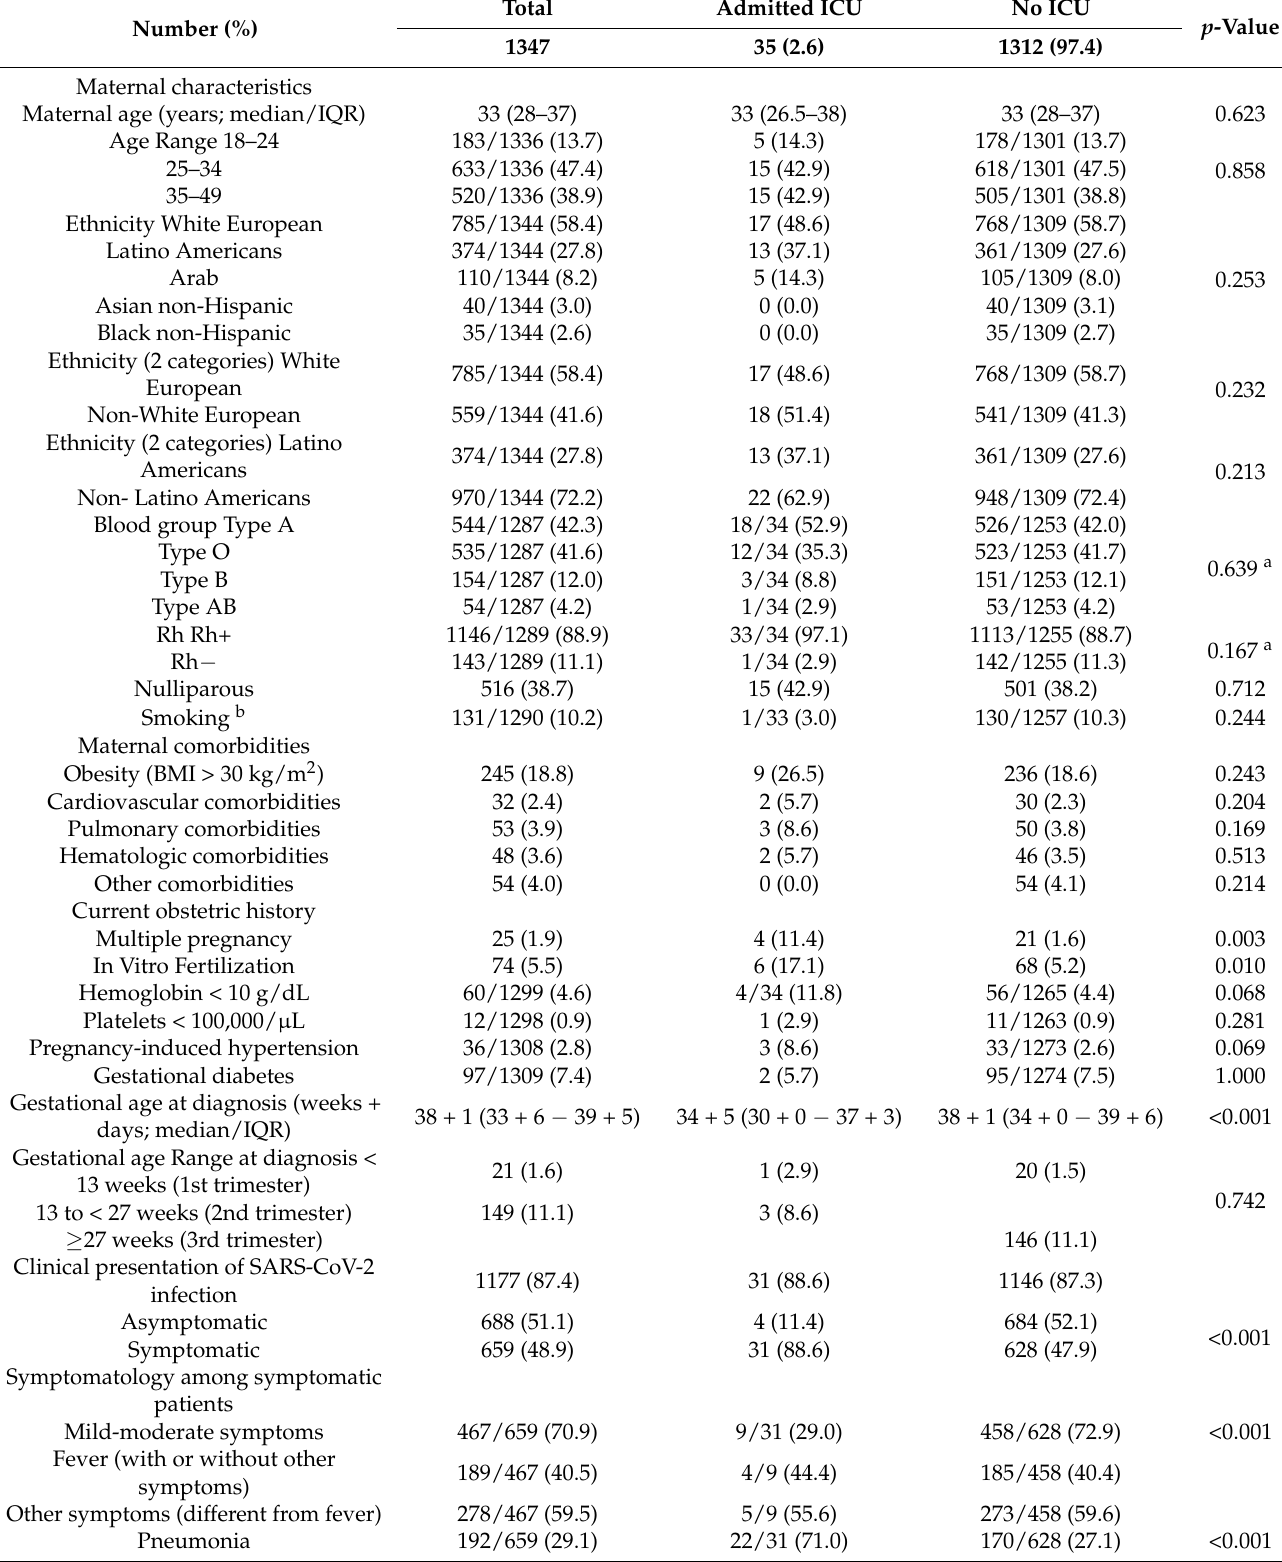
Table 1. Demographic characteristics, comorbidities, current obstetric history, clinical presentation of SARS-CoV-2 infection and analytics of the study participants (n =